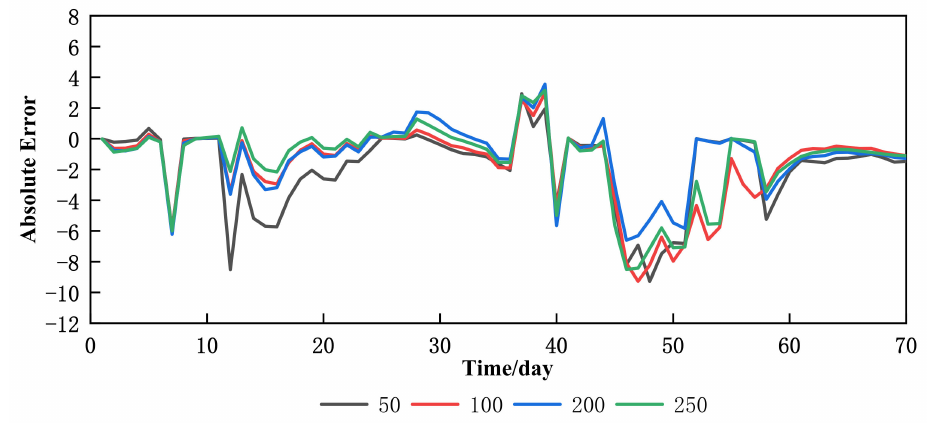
Figure 15. Absolute error variation of the assimilation under different numbers of